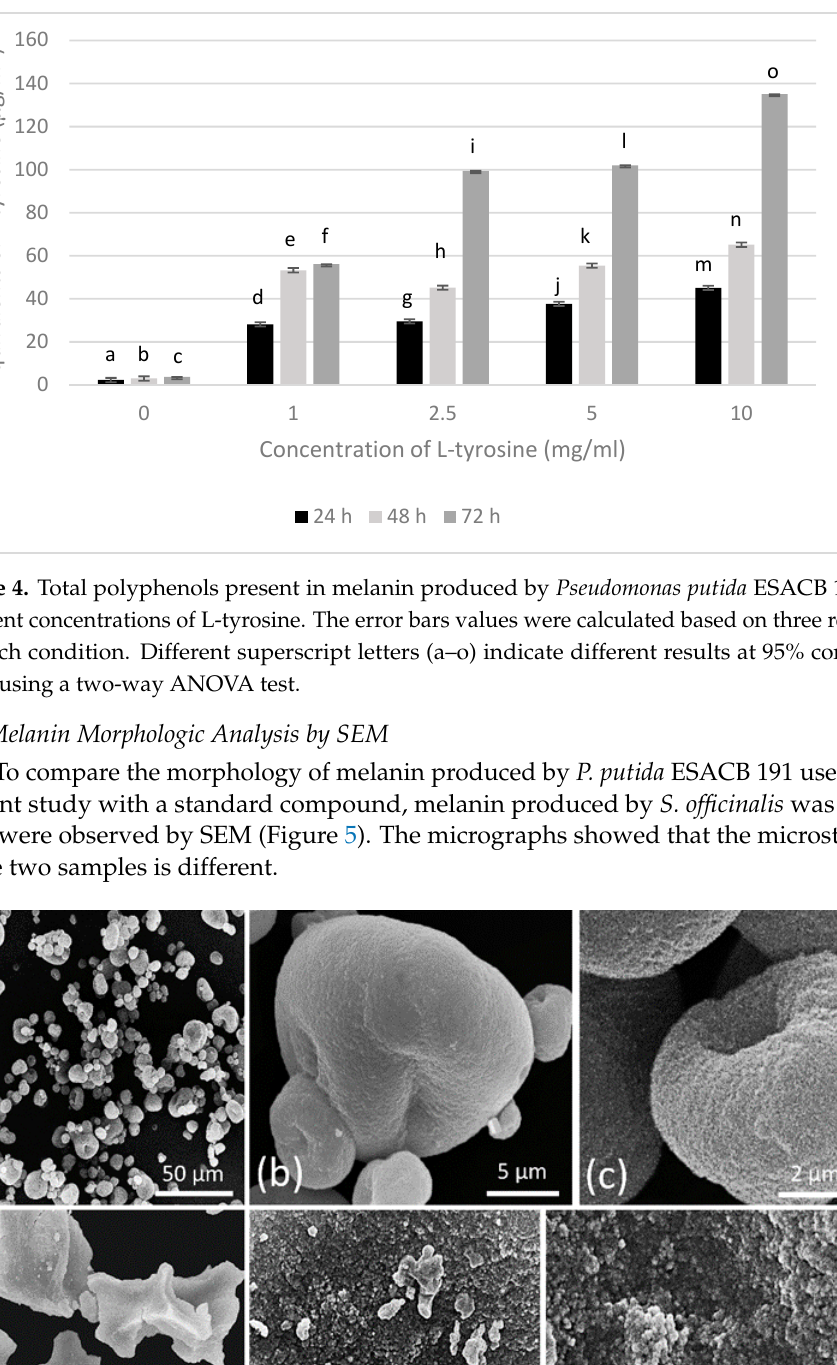
ESACB 191 melanin ( d – f ). ( a ) General view, showing S. officinalis melanin aggregates with different sizes; ( b ) enlarged view of some melanin aggregates; ( c ) detail of the S. officinalis melanin aggregate surface; ( d ) lyophilized fragments of the extracted melanin; ( e , f ) enlarged views of melanin extracted fragments.